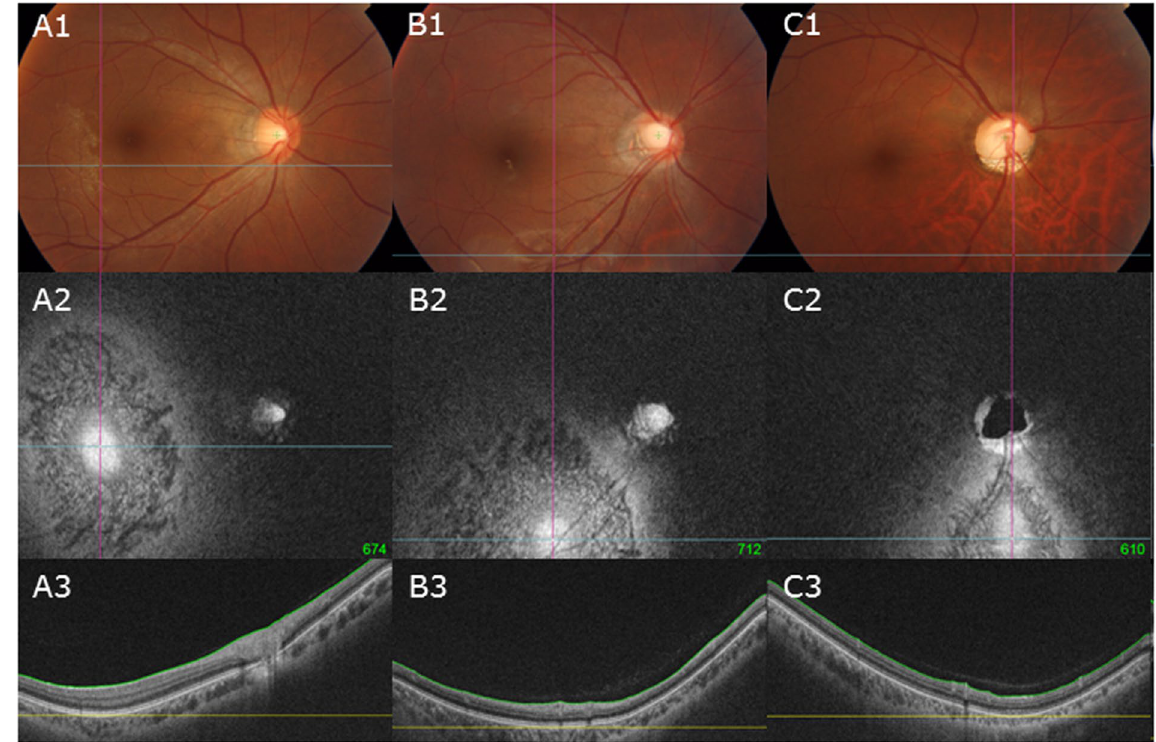
Figure 4. Representation of the classification of the four groups by increasing optic disc torsion (section A1 to C1). ( A ) Mild torsion group represented relatively normal ONH appearances measuring less than 30 degrees of optic disc torsion. ( B ) Moderate torsion group represented myopic tilted disc appearances measuring 30 to 60 degrees of optic disc torsion. ( C ) Severe torsion group represented TDS appearances measuring 60 to 90 degrees of optic disc torsion. Section A2–C2 shows the coronal section and section A3–C3 shows the horizontal section of each subject,